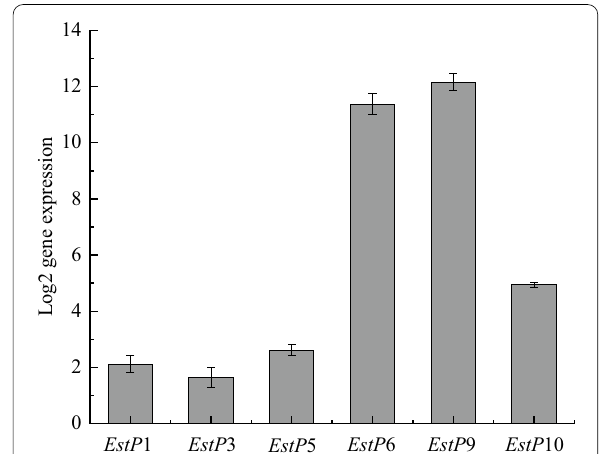
Fig. 6 Relative expression of genes in C. freundii CD-9 under the presence of fenvalerate. All data are expressed as means deviation